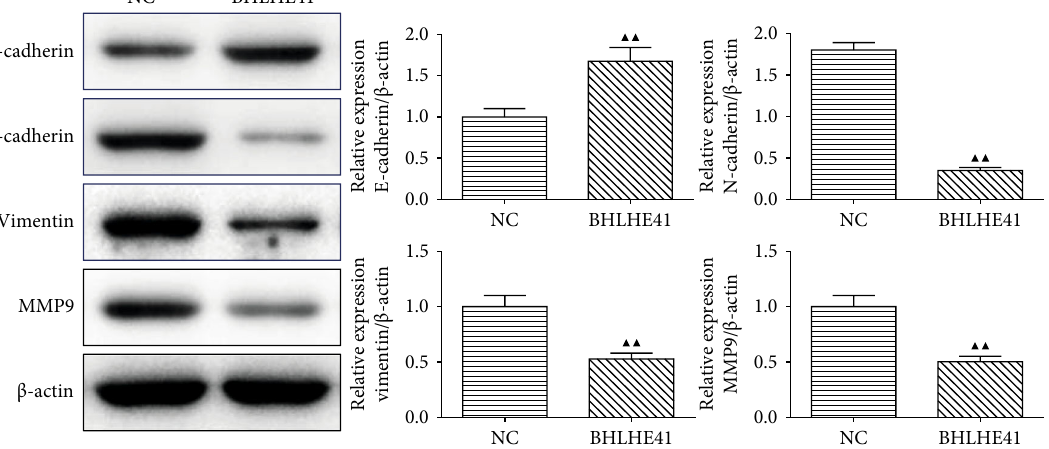
Figure 10: BHLHE41 overexpression alleviated the EMT-related factors level in tumor tissues. The EMT-related markers in tumor tissues were tested by Western blot. All experiments have been performed in triplicate, and data were expressed as mean ± SD . ▲▲ P < 0 : 01 vs.